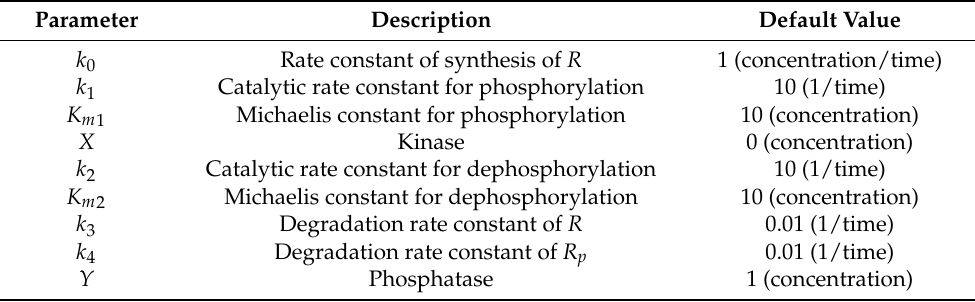
Table 1. Default parameter values for the MM model in Figure 1C.